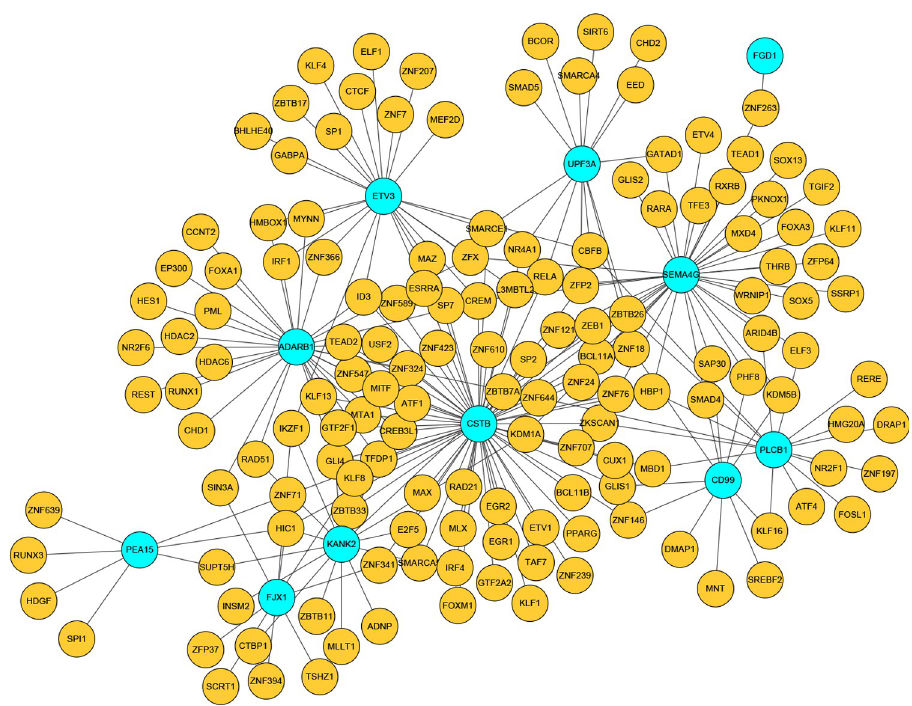
Fig 6. TF-gene interaction network based on common DEGs. Nodes in green color indicated common DEGs, and nodes in yellow color indicated TF genes.